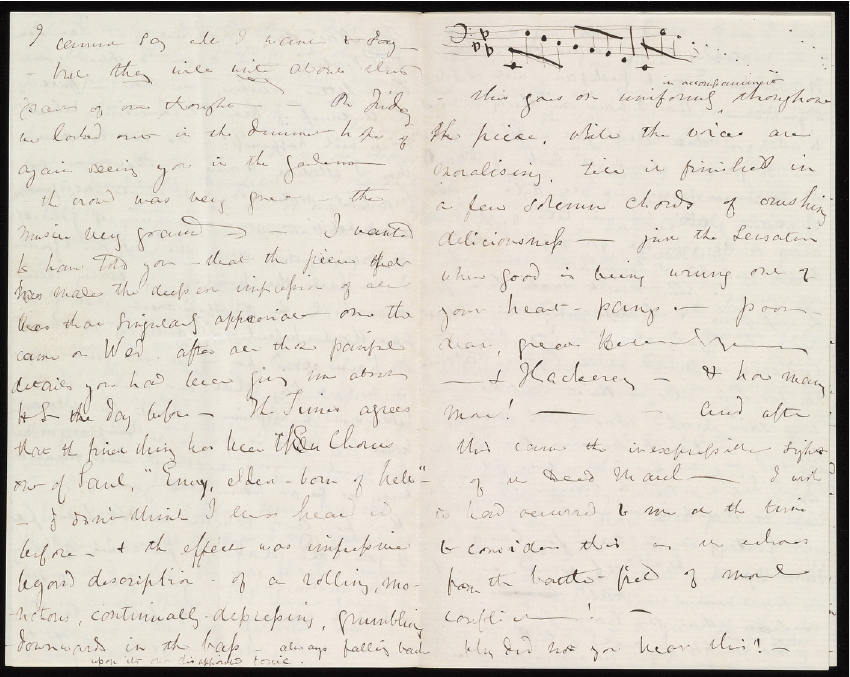
Fig. 1 : Manuscript letter from Sara Sophia Hennell, 26 June 1859, Yale University Library, Beinecke Rare Book and Manuscript Library. © Jonathan Garnault